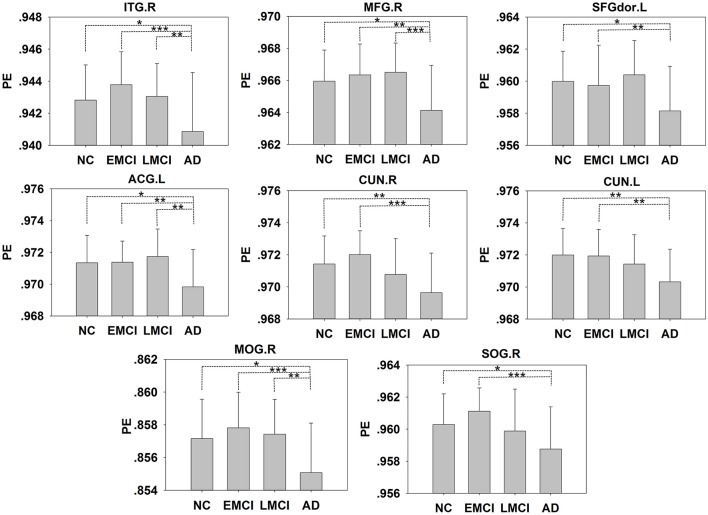
The PE values of the NC, EMCI, LMCI, and AD subjects. Significant differences between pairs of groups after Bonferroni correction (P < 0.05) are indicated. *P < 0.05, **P < 0.01, ***P < 0.001. The error bars indicate the SDs.